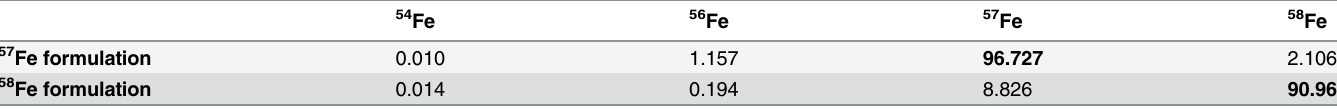
Table 3. Abundances of stable iron isotopes used in the experiment (%).